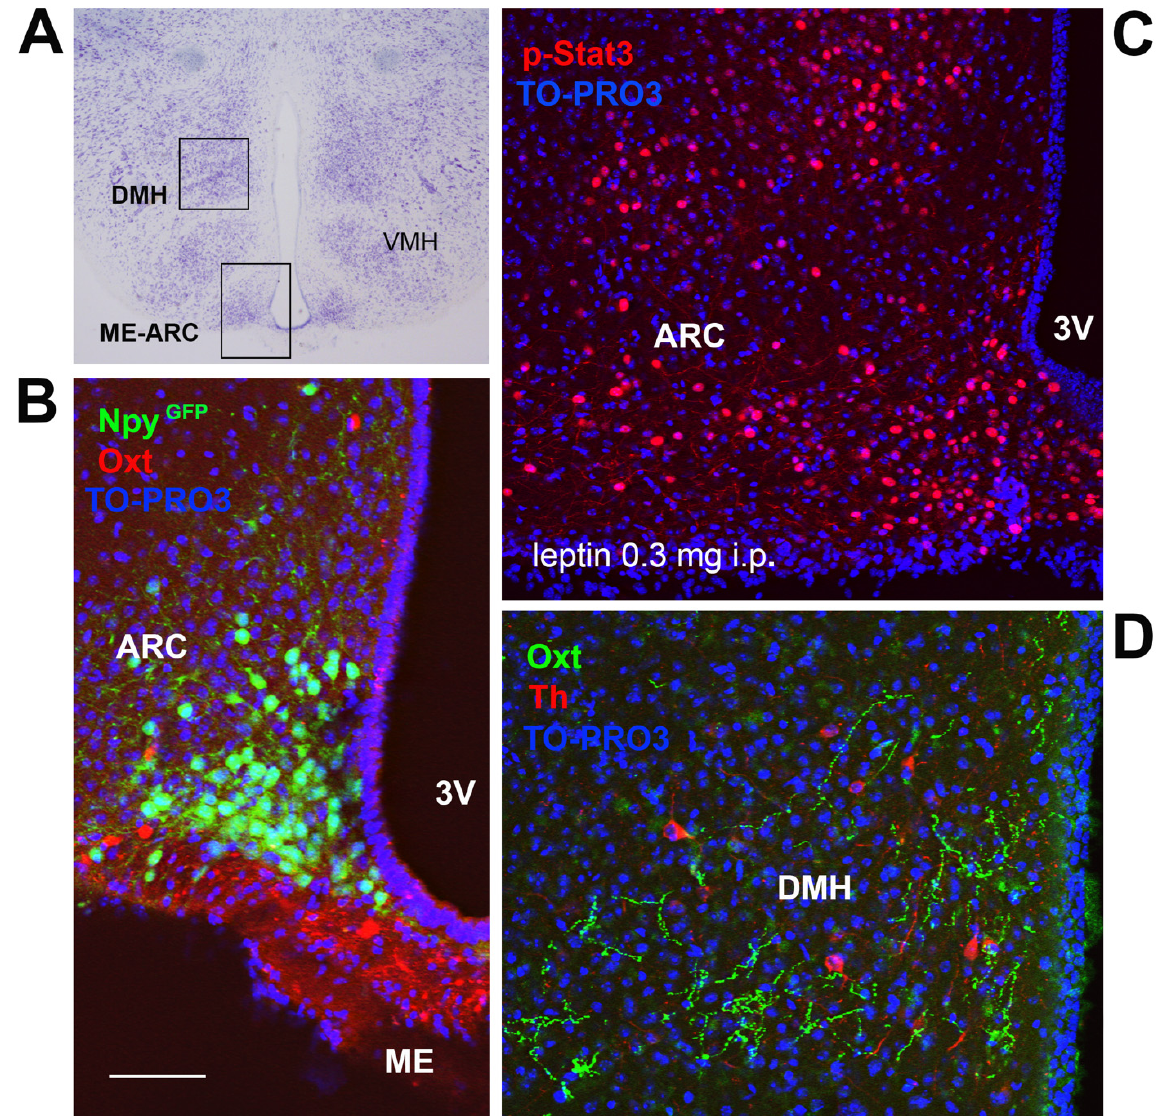
Figure 3. Hypothalamic nuclei regulating energy homeostasis. ( A ) Light microscopy: Nissl-stained brain coronal section of the region corresponding to bregma − 3.13 mm, which includes the arcuate nucleus (ARC), median eminence (ME), dorsomedial hypothalamus (DMH), and ventromedial hypothalamus (VMH). ( B ) Confocal microscopy (CM) of oxytocin (Oxt) neurons and projections in close proximity of NPY neurons in the ARC-ME area from an NPY Cre ; R26 GFP adult male mouse. ( C ) CM: p-Stat3-positive neurons in ARC-ME, 50 min following intraperitoneal (i.p.) injection of recombinant leptin (0.3 mg). p-Stat3 positivity indicates leptin-responsive neurons. ( D ) CM of DMH oxytocinergic projections; red staining indicates tyrosine hydroxylase (Th)-positive neurons. 3V: third ventricle; cell nuclei (blue) are marked using TO-PRO3 staining. Figure ( A – D ) refer to a 6-month-old male C57BL/6 mouse. Bregma reference sections from “The Mouse Brain Atlas”, Paxinos and Franklin (2001). The scale bar is only specified in C and corresponds to different µ m in each figure, as follows: in ( A ): 400 µ m; in ( B ): 50 µ m; in ( C ): 65 µ m; in ( D ): 40 µ m. All figures are original. Methodological details are included in the Supplementary Materials